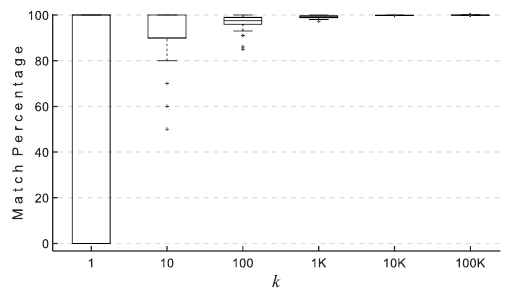
Figure 4 Match percentage of Postgres-v1 and Postgres-v2 It appears that Postgres-v1 and Postgres-v2 identified different portions of the points occurring at exact locations as the nearest neighbour; hence, both no match and perfect match were observed. As the value of k increases, so does the match percentage between different Postgres approaches. Specifically, the match percentage rises from 97.50% to 99.95% as k increases from 10 to 100K. The remaining part of the analysis relied on Postgres-v2 as it executes faster.